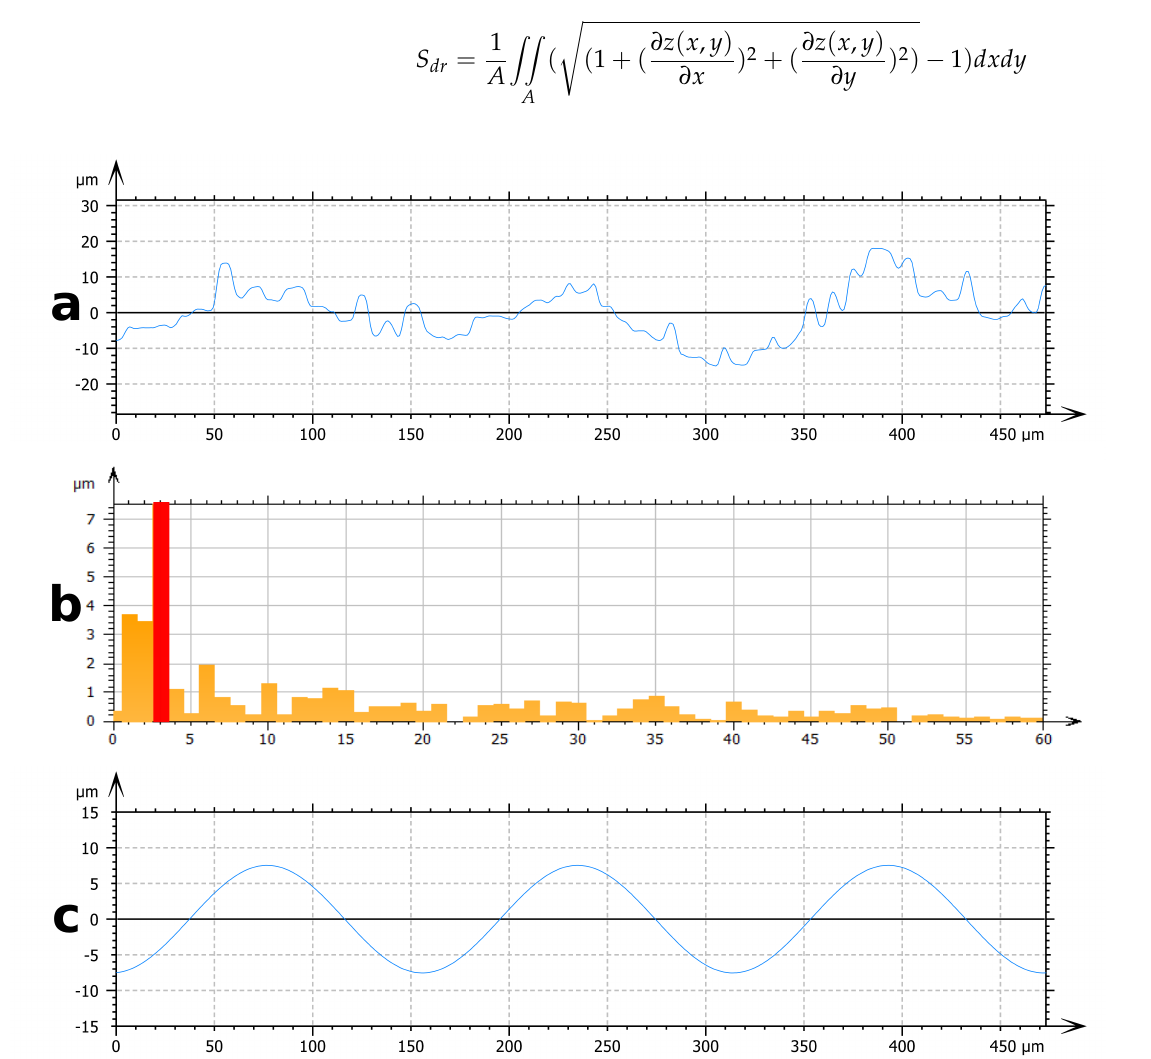
Figure 3. Example of frequency filtering by FFT: ( a ) unprocessed profile of Phyllostachys Bamboo leaf, ( b ) frequency spectrum with in red the selected frequency, and ( c ) filtered